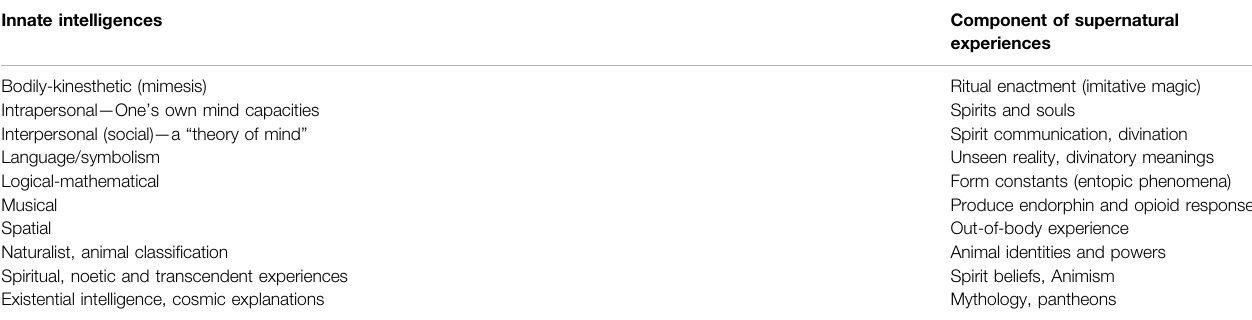
TABLE 1 | Gardner ’ s innate intelligences and supernatural